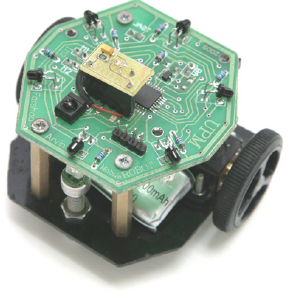
Fig. 1. AMiR mobile robot, open-hardware swarm robotic platform